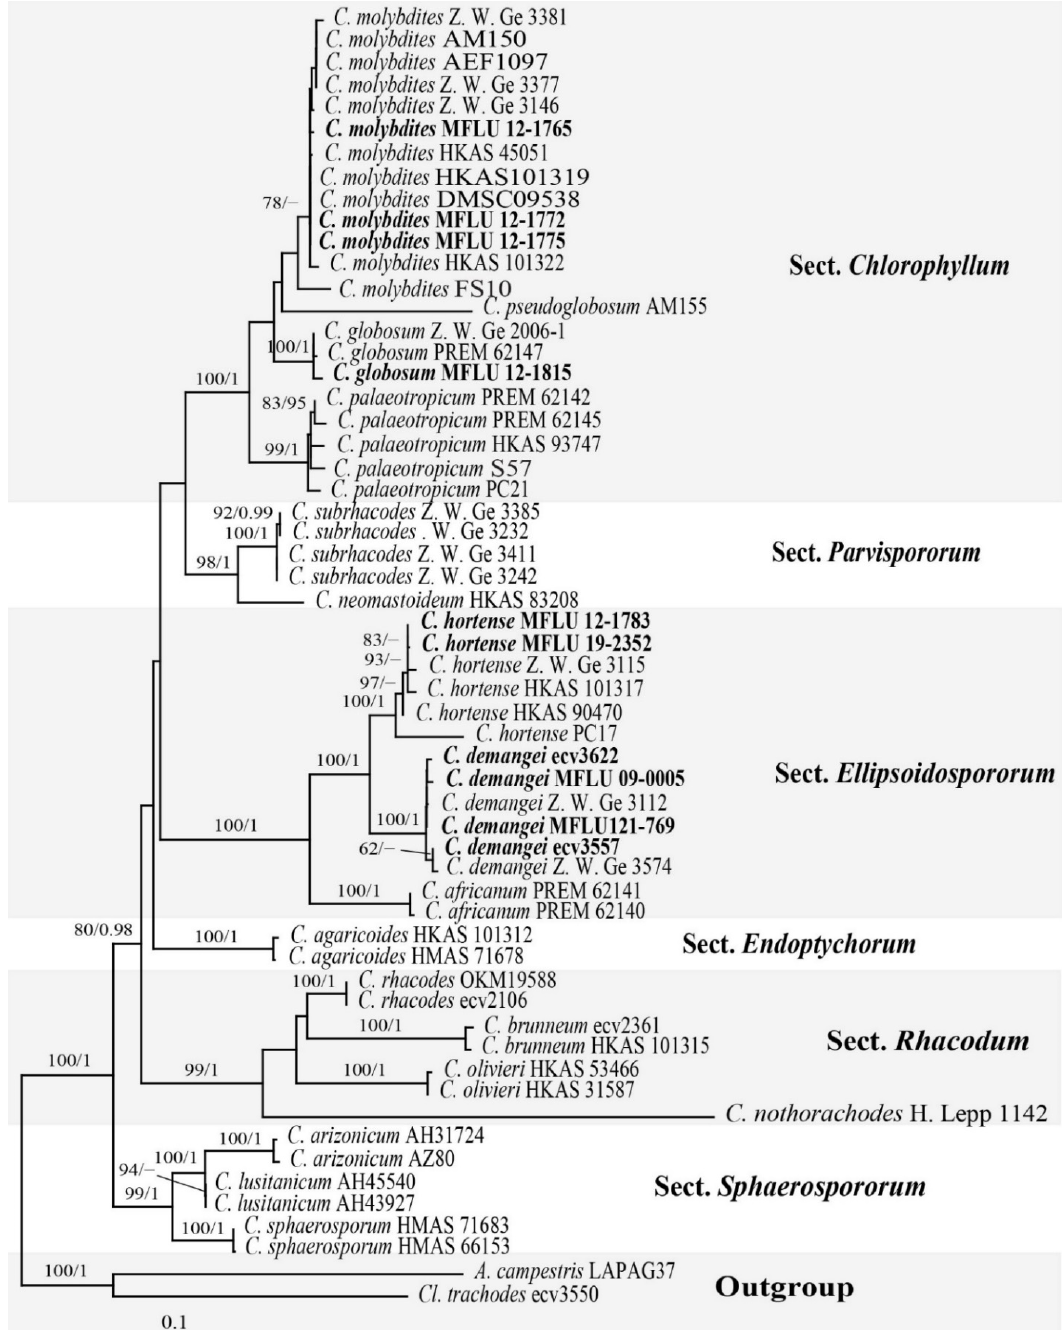
Figure 3. Maximum Likelihood tree of Chlorophyllum based on analysis of nrITS-LSU- rpb2 sequence data. Bootstrap values (ML/B) are given above the branches. Bootstrap values for maximum likelihood equal to or greater than ≥ 60 and Bayesian posterior probabilities ≥ 0.95 are placed above the branches. Abbreviations are as follows: A. = Agaricus , C = Chlorophyllum , and Cl = Clarkeinda . Clarkeinda trachodes and Agaricus campestris are used as outgroup. New sequences are in bold type.